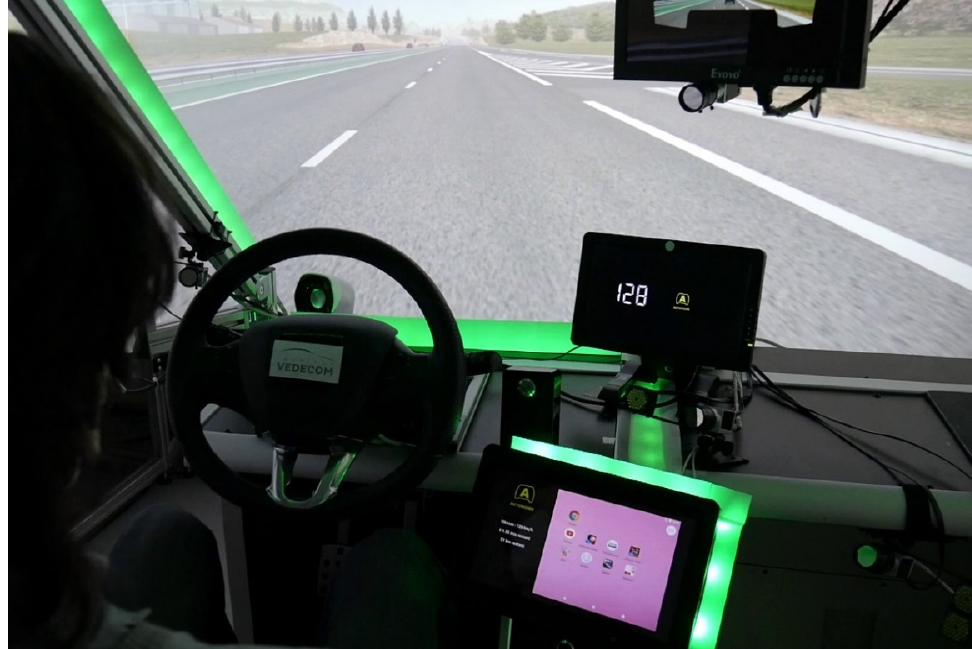
Figure 1. Close-up view of the apparatus (here, the LED stripe is green).